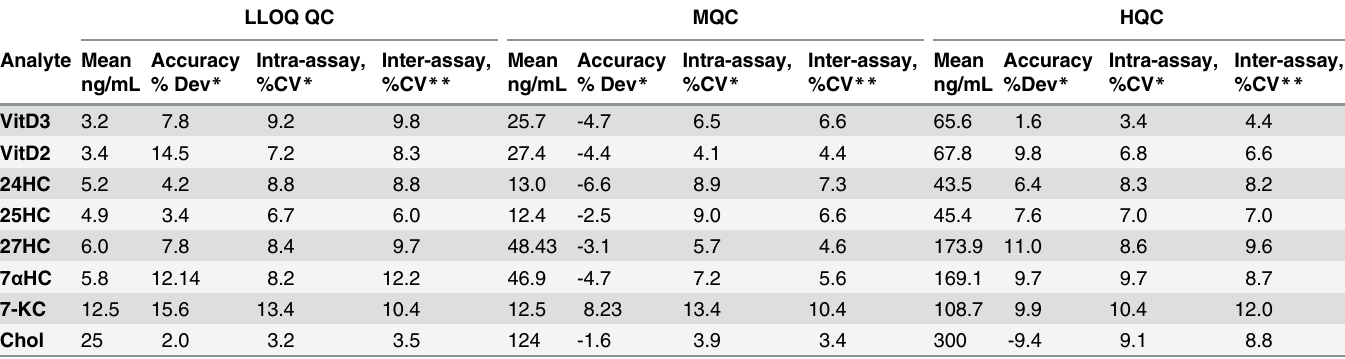
Table 2. Intra- and inter-assay imprecision for method validation